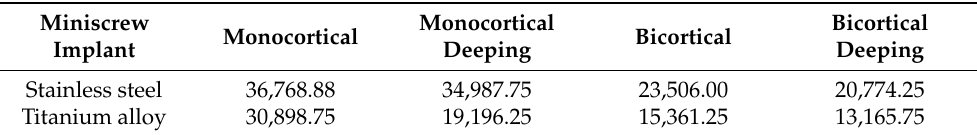
Table 3. Mean von Mises stress (MPa) of the miniscrew implants for the skull. model with midpalatal suture for all 4 anchorage